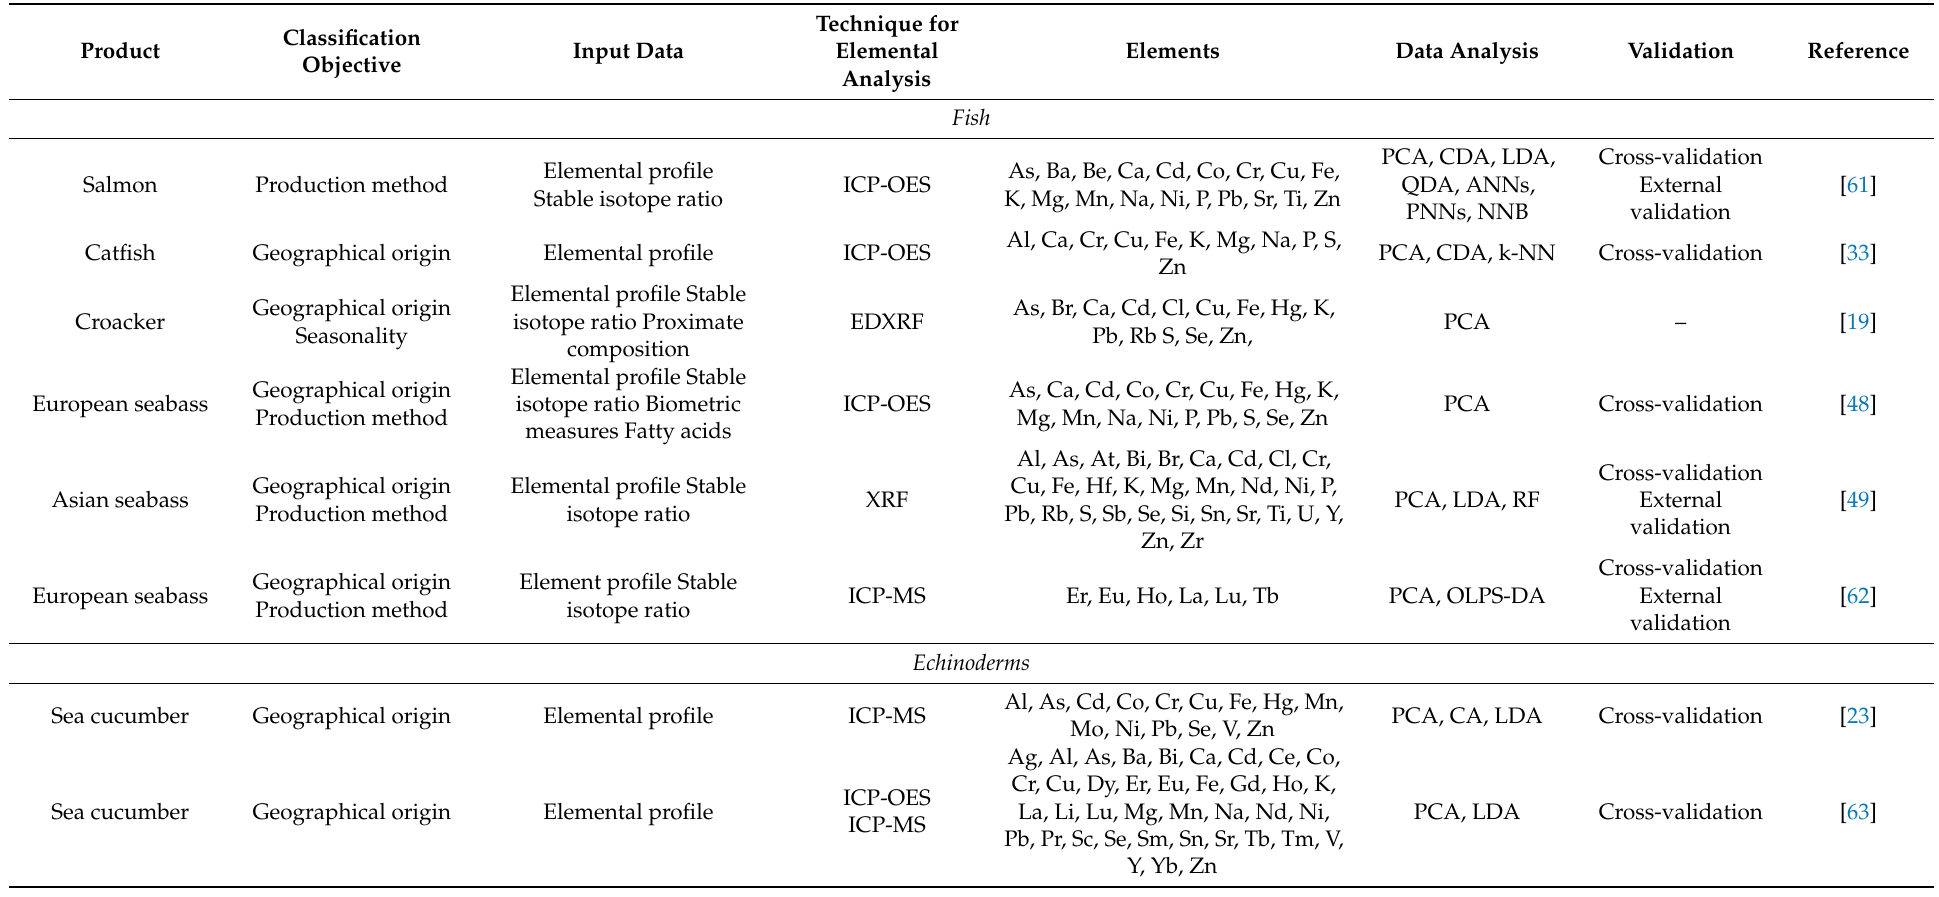
Table 1. Overview of the literature dealing with multi-elemental profile for fish and seafood authenticity